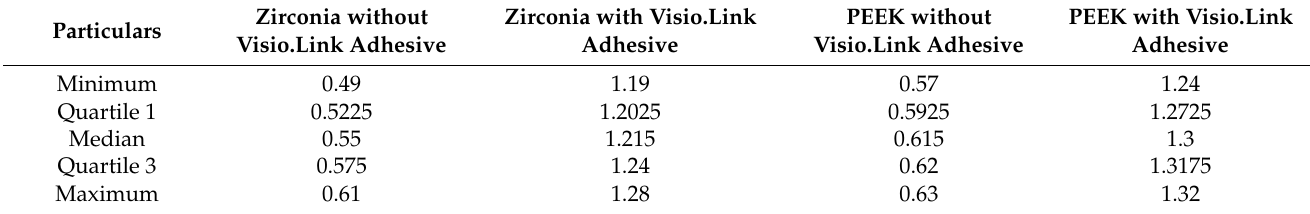
Figure 10. Comparison of mean tensile bond strength of poly ether ether ketone (PEEK) and Zirconia with and without visio.link adhesive.Vertical Axis: 1—Zirconia without Visio.link adhesive, 2—Zirconia with Visio.link adhesive, 3—PEEK without Visio.link adhesive, 4—PEEK with Visio.link adhesive. Table 3. Particulars of mean tensile bond strength of poly ether ether ketone (PEEK) and Zirconia with and without visio.link adhesive.